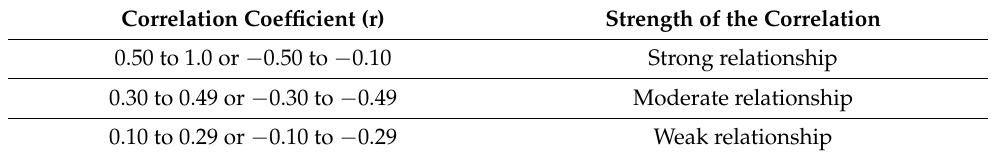
Table 7. Correlation coefficient